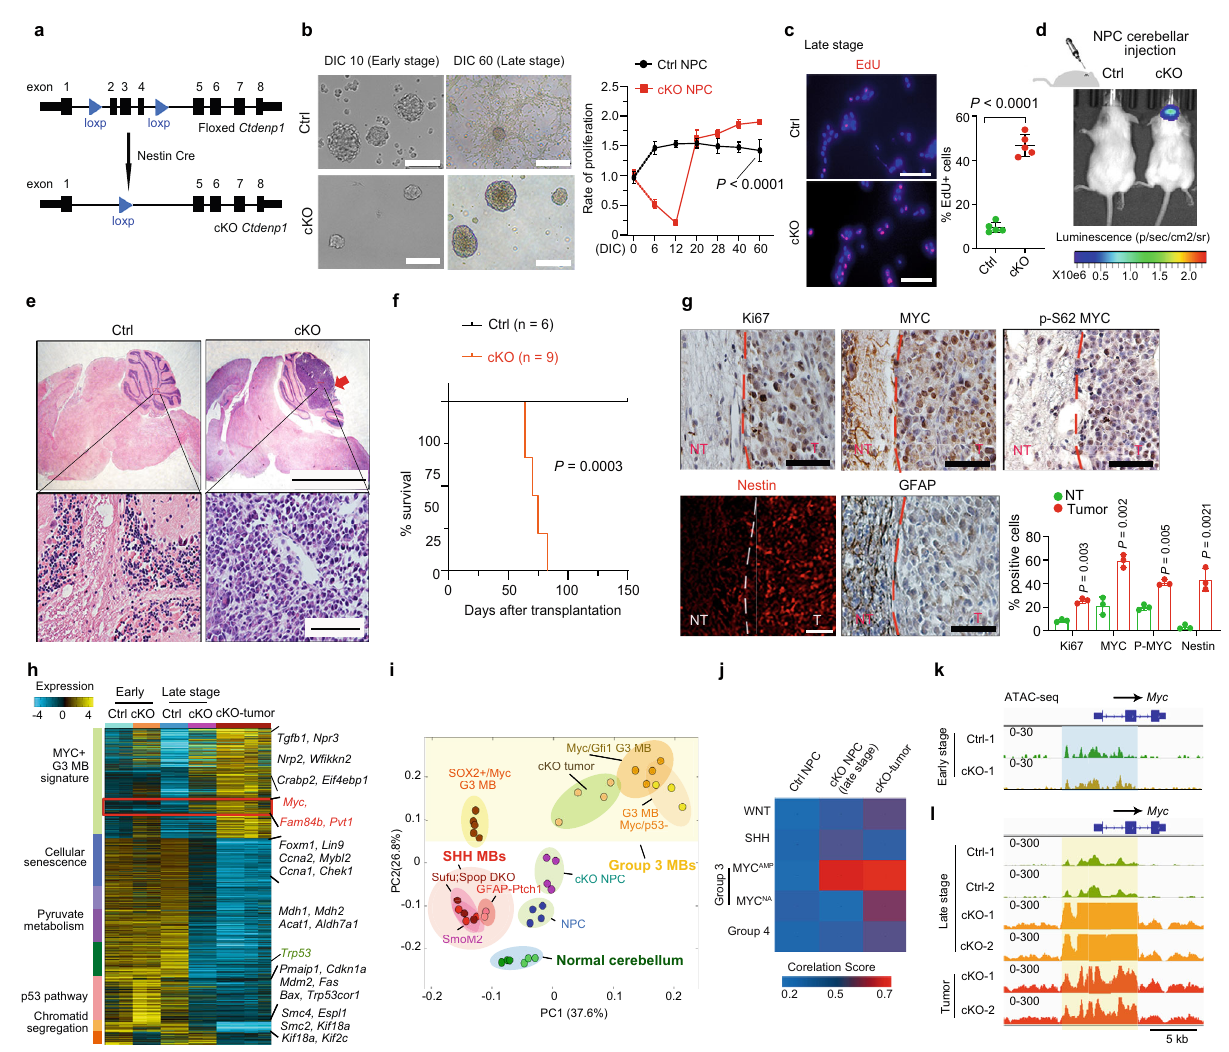
Fig. 4 | Ctdnep1 ablation in cerebellar NPCs induces G3 MB-like tumor forma- tion. a Diagram depicting the generation of Ctdnep1- cKO mice. b Left and middle, representative images (left) of Ctdnep1- cKO NPCs (cKO) and control (Ctrl) NPCs at differentstages.Right,relativeproliferativeratesofcontroland Ctdnep1 -cKONPCs at the different stages of in vitro culture (right). n =5 independent experiments. Scale bars: 100 μ m. c Left: Representative images of EdU stained control and Ctdnep1- cKO NPCs. Scale bar: 100 μ m. Right: Percentages of EdU+ cells ( n =5 independent experiments) in Ctdnep1- cKO or WT NPC at late-stage (DIC 60). d Representative bioluminescence imaging of mice transplanted with WT or Ctdnep1- cKO NPCs at 65 days post-transplantation. e Hematoxylin and eosin staining of cerebellum sections with WT or Ctdnep1- cKO NPCs transplantation. Scale bars: 5mm (upper) and 100 μ m (lower). n =5 independent allografts/group. f Survival curves for animals transplanted with Ctrl and Ctdnep1- cKO NPCs. Log- rank test. g Representative immunostaining and quanti fi cation of the labeled cells in tumor and para-tumor regions from Ctdnep1- cKO NPCs transplanted cerebella.